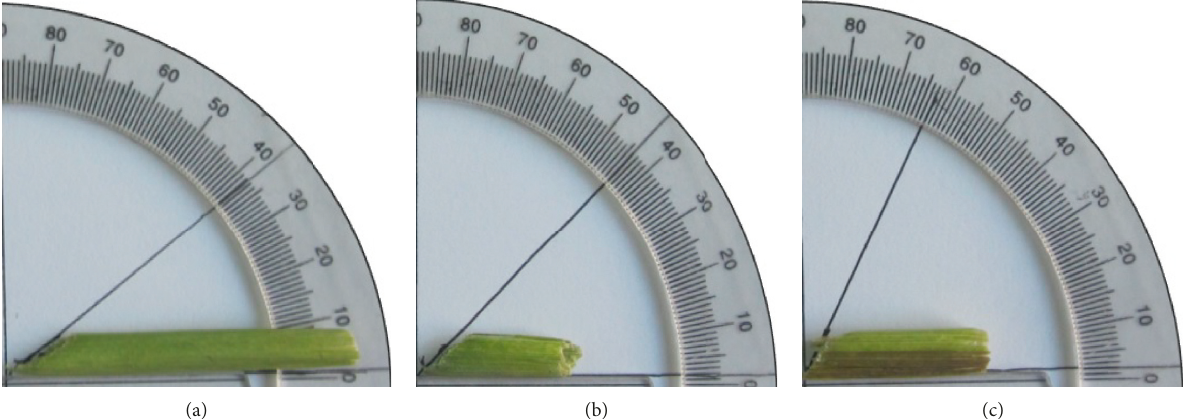
Figure 22: Cutting surface angle of stems at different forward speeds. (a) Surface angle 38 ° . (b) Surface angle 44 ° . (c) Surface angle 62 °